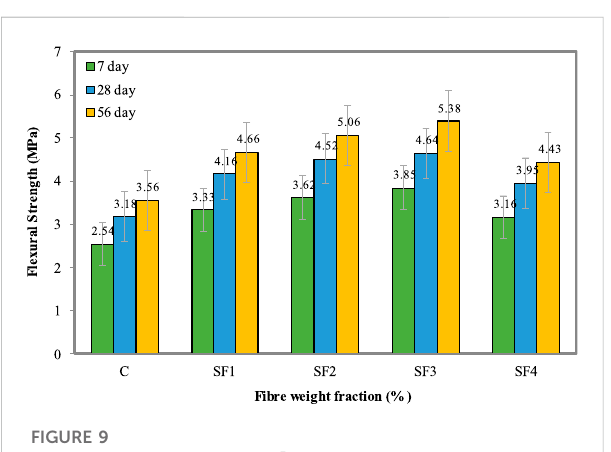
FIGURE 12 Tensile strength of 1,600 kg/m 3 FC density with varying weight fractions of